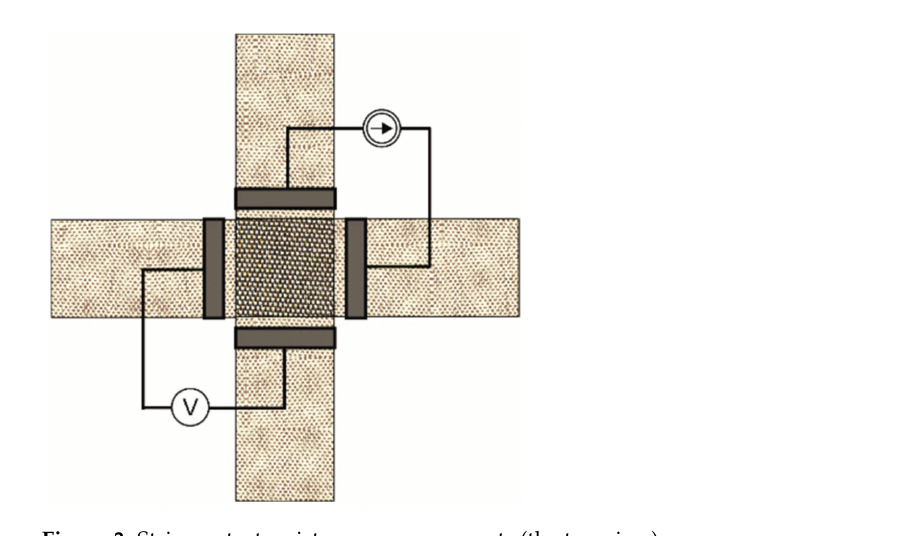
Figure 3. Strip contact resistance measurements (the top view).